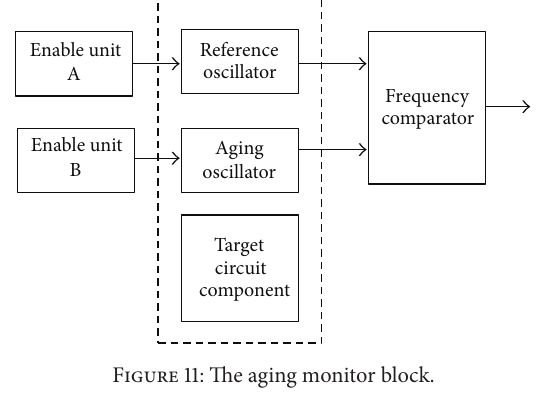
Figure 11: The aging monitor block.